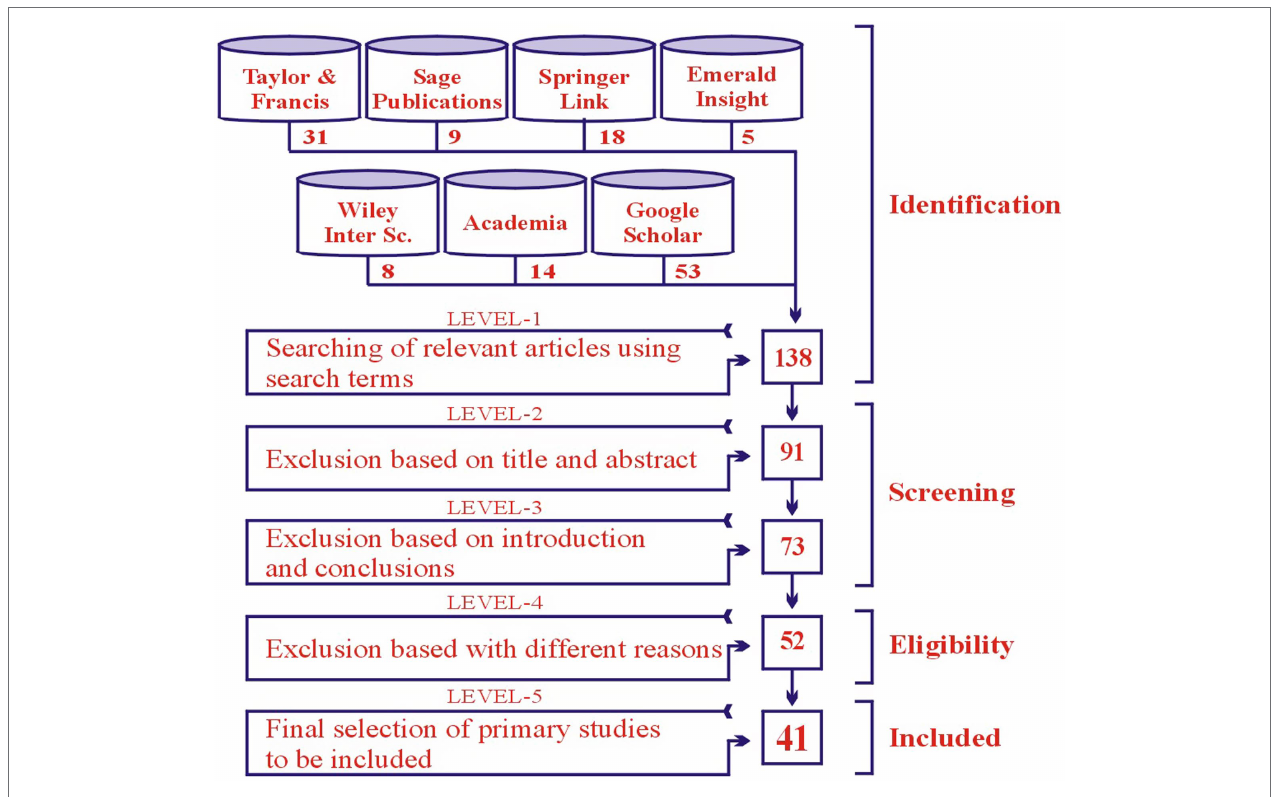
FIGURE 2 | Selection of primary studies through PRISMA